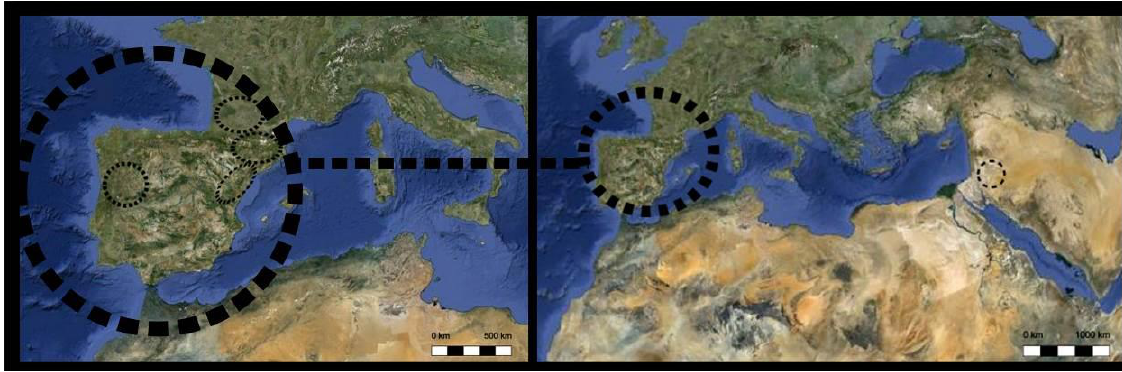
Figure 3. Map with the geographical areas studied. Source: Google Earth